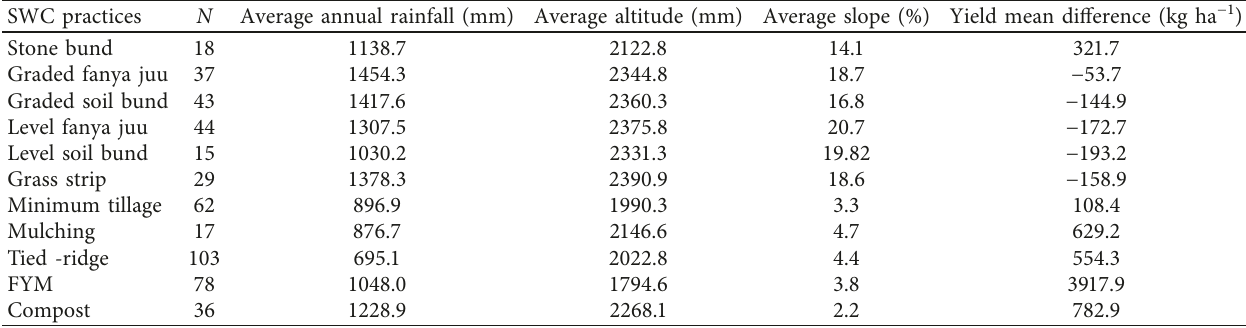
Table 8: Impact of soil and water conservation practices on grain yield (mean difference) of crops (kg ha − 1 ) related to rainfall, altitude, and slope